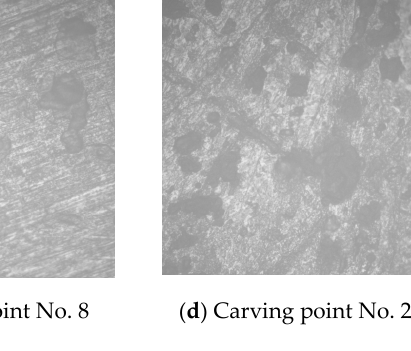
Figure 15. ( a – d ) Wear on the surface of guide vane ( P = 30.9 MW).